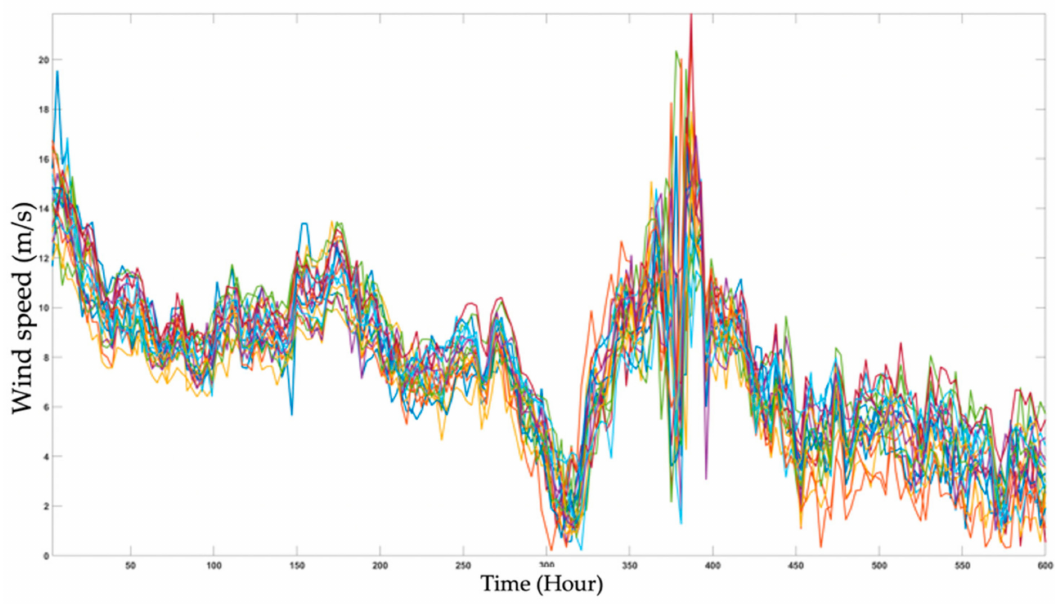
Figure 6. Results of data preprocessing using WEPS ensemble